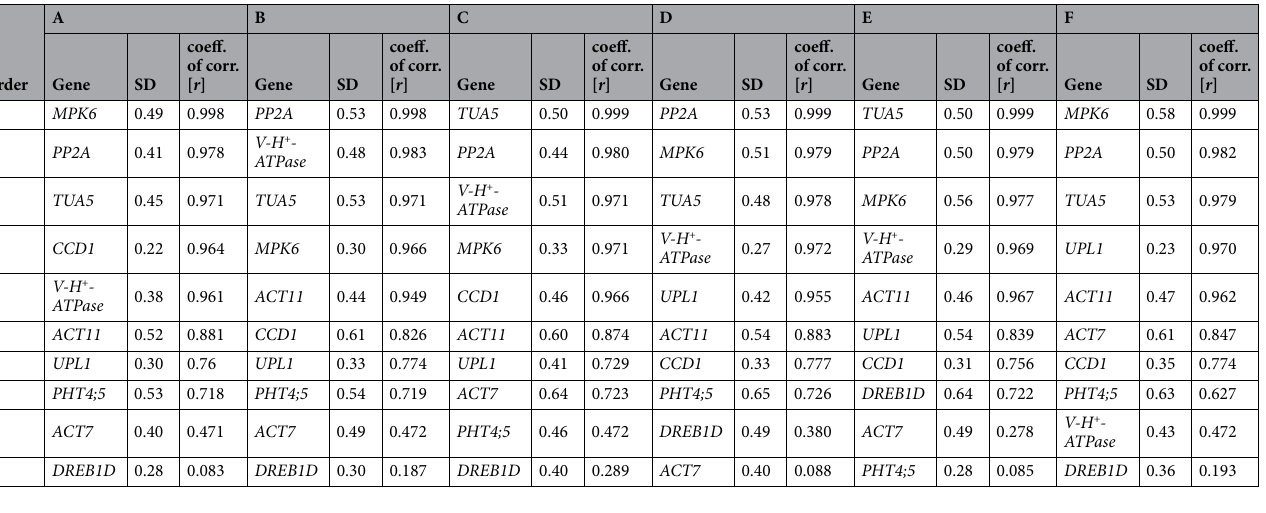
Table 3. Stability assessment of all candidate reference genes of S. glauca plants’ response to salinity stresses calculated using the BestKeeper algorithms. A: Thirteen tissue samples derived from 1/10 MS liquid medium treatment. B: Thirteen tissue samples derived from 100 mM NaCl treatment. C: Thirteen tissue samples derived from 300 mM NaCl treatment. D: Fifteen germinating seed samples derived from NaCl gradient treatment. E: Eighteen seedling samples derived from NaCl gradient treatment. F: All 72 samples used in this